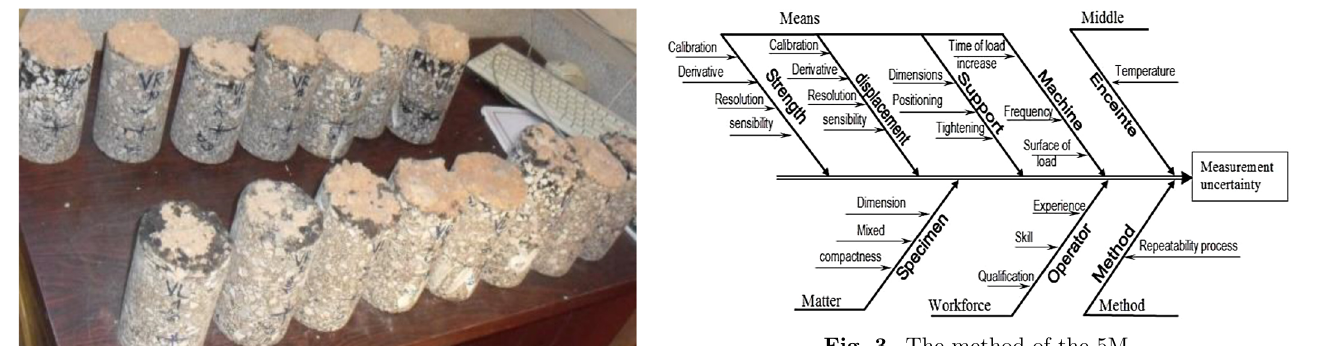
Fig. 3. The method of the 5M.